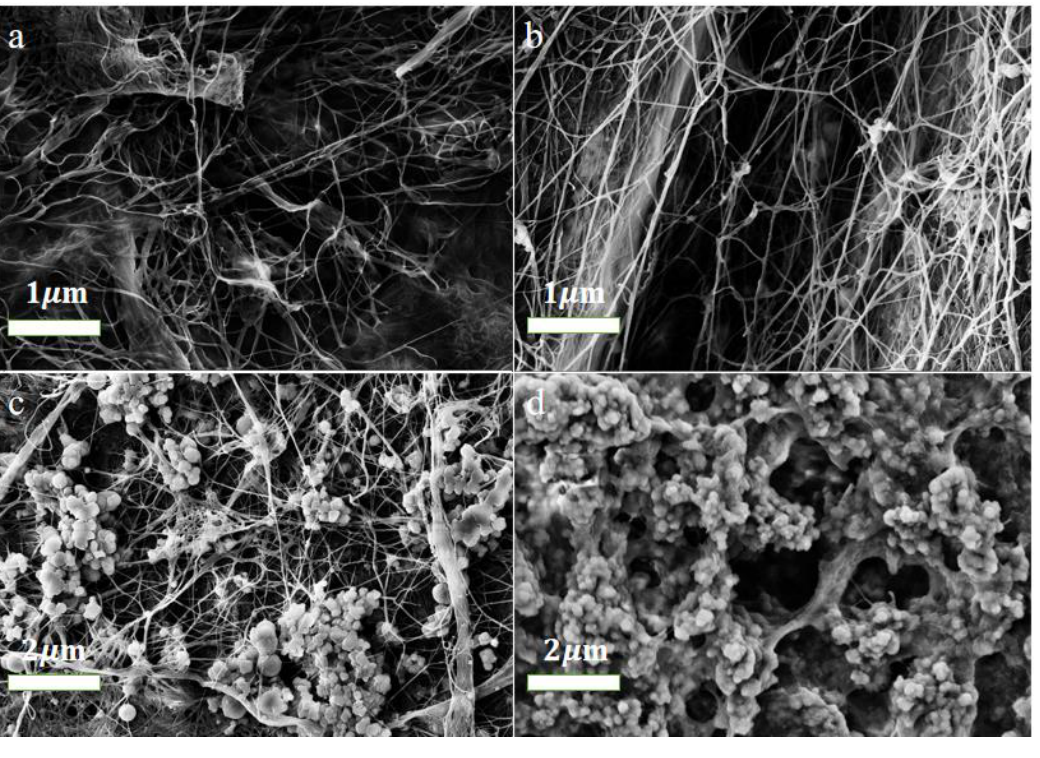
Figure 1. ( a ) SEM images of BC membrane. ( b ) BC adhesive PDA composite membrane. ( c ) TiO 2 composite membrane was supported by BC adhesive PDA and ( d ) BTA.